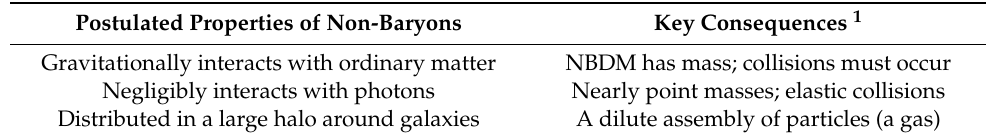
Table 1. Properties of dark matter halos according to